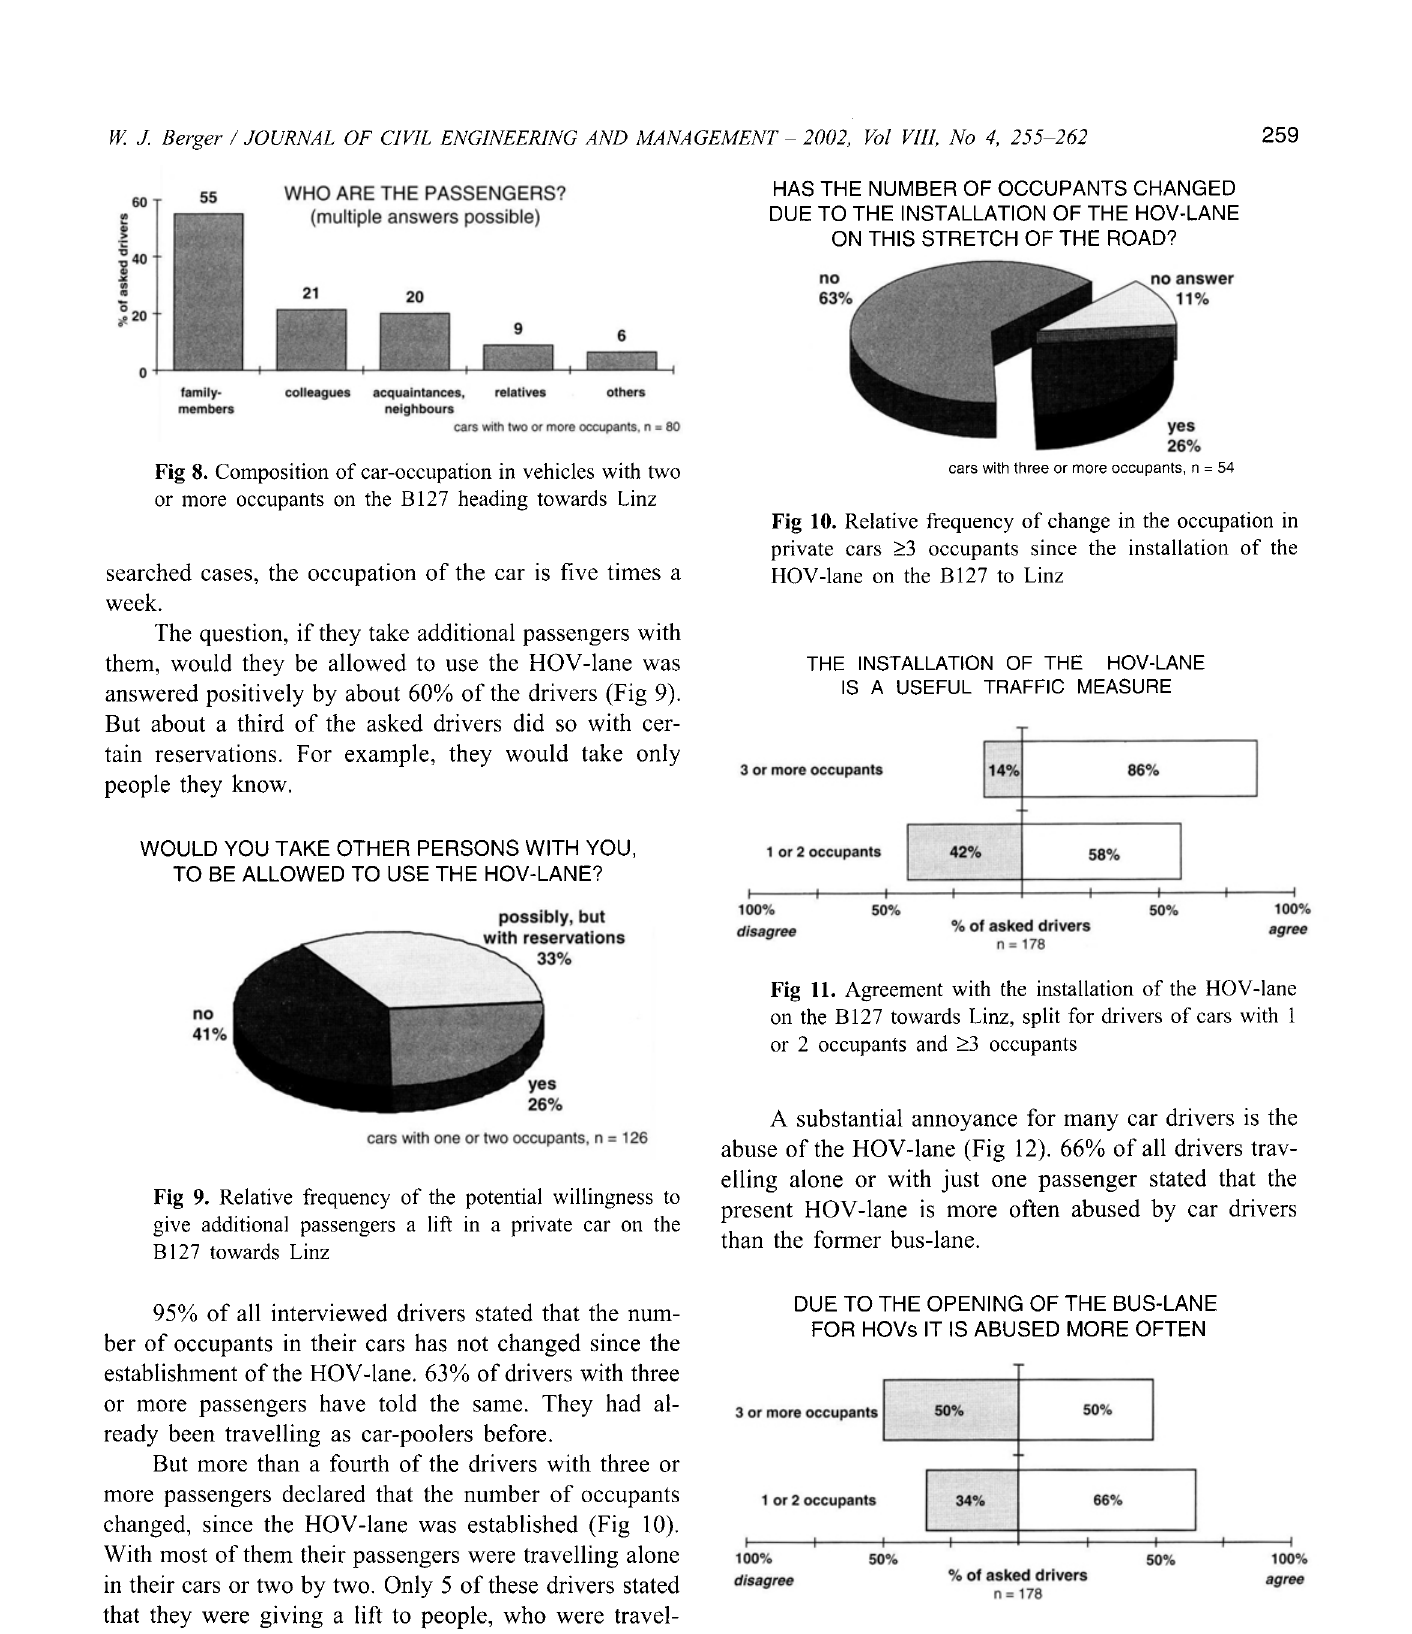
Fig 12. Judgement of the frequency of abuse of the HOY lane on the B 127 towards Linz, split for drivers of cars with 1-2 occupants and :2:3